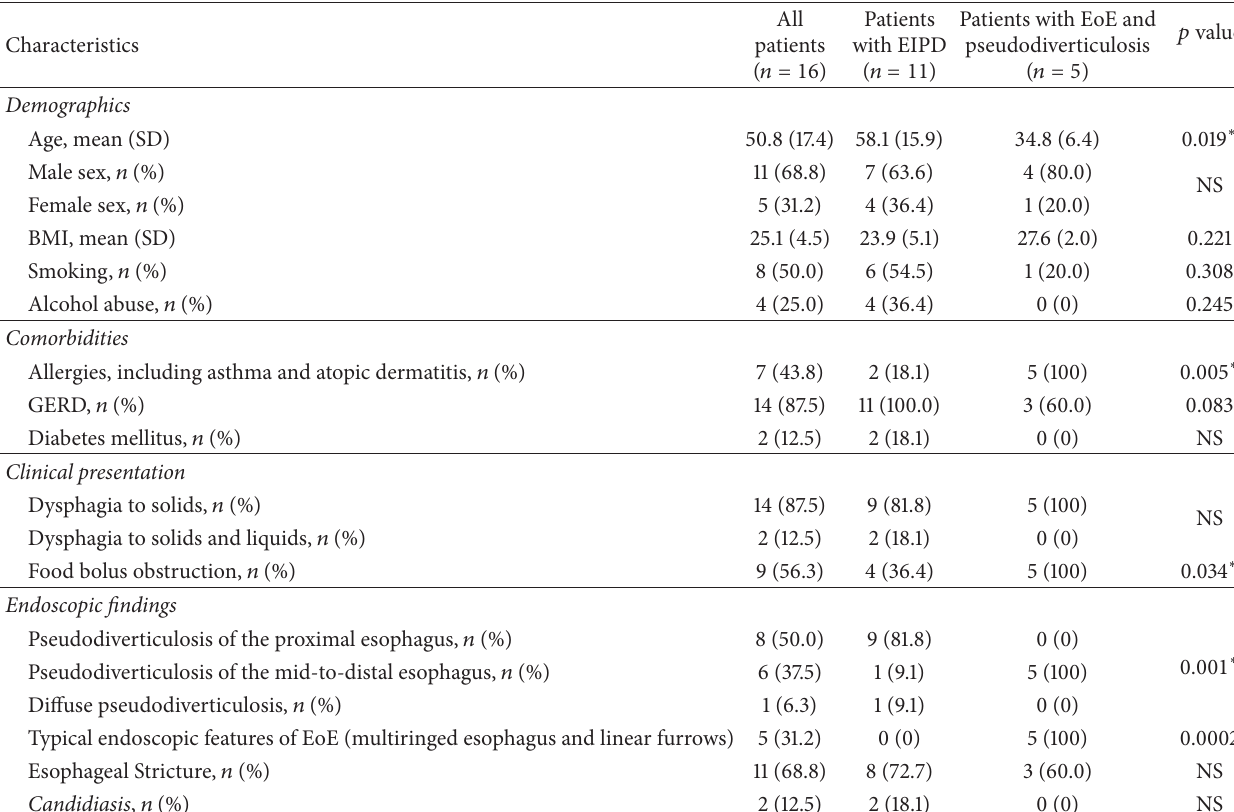
Table 1: Demographics, comorbidities, clinical presentation, and endoscopic and histologic findings for all patients, including the subgroup analysis of patients with EIPD and with EoE and pseudodiverticulosis.